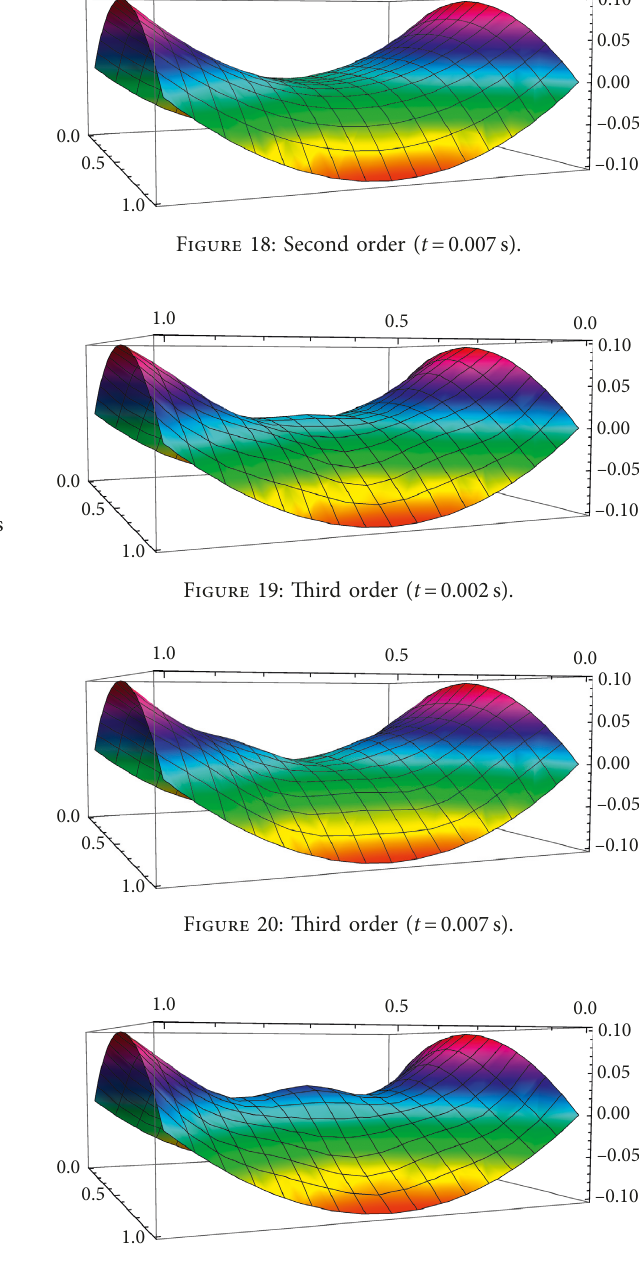
Figure 21: Superposing of the first three orders ( t � 0.002s).